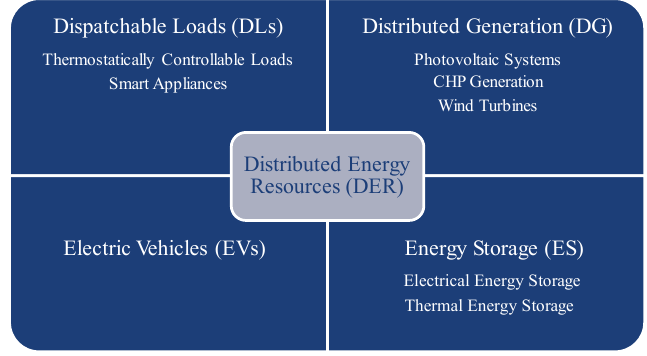
Figure 1. Distributed Energy Resource (DER)